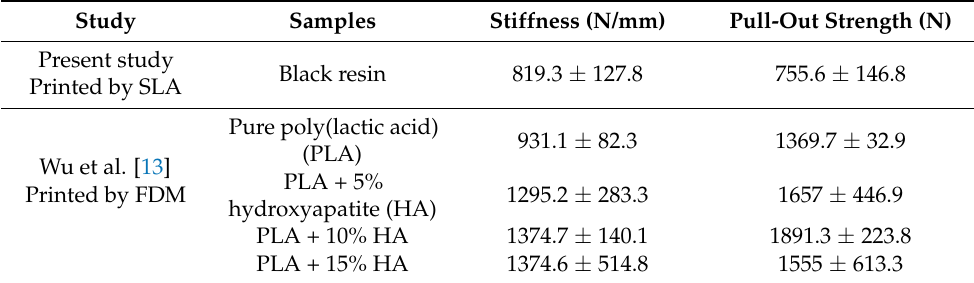
Table 5. Pull-out test results comparison between present study (screw diameter of 6.7 mm) and previous study (screw diameter of 6.5 mm), using the same input model, the same scale factor (4.3) and the same type of screw, with an insertion depth of 20 mm. The same test setup was used for both fused deposition modelling (FDM) and stereolithography (SLA) printed samples. The mean values and standard deviations are presented.